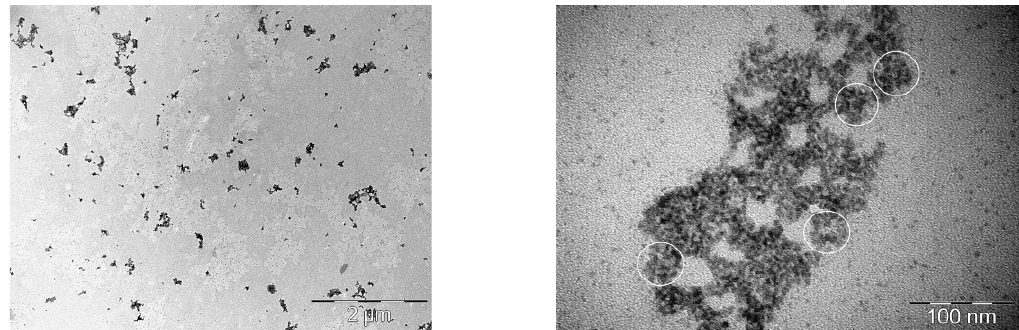
Figure 1. TEM micrographs of ZnS dispersions at 0.5 o C. Overall view of ZnS flocs (left), detail view of one ZnS floc.